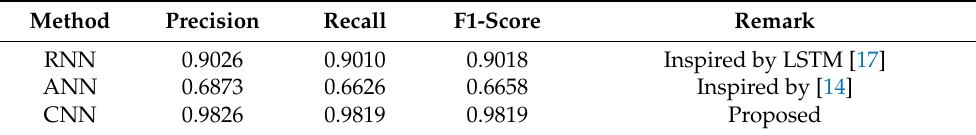
Table 3. The performance of different neural network learning methods with evaluation indicators.